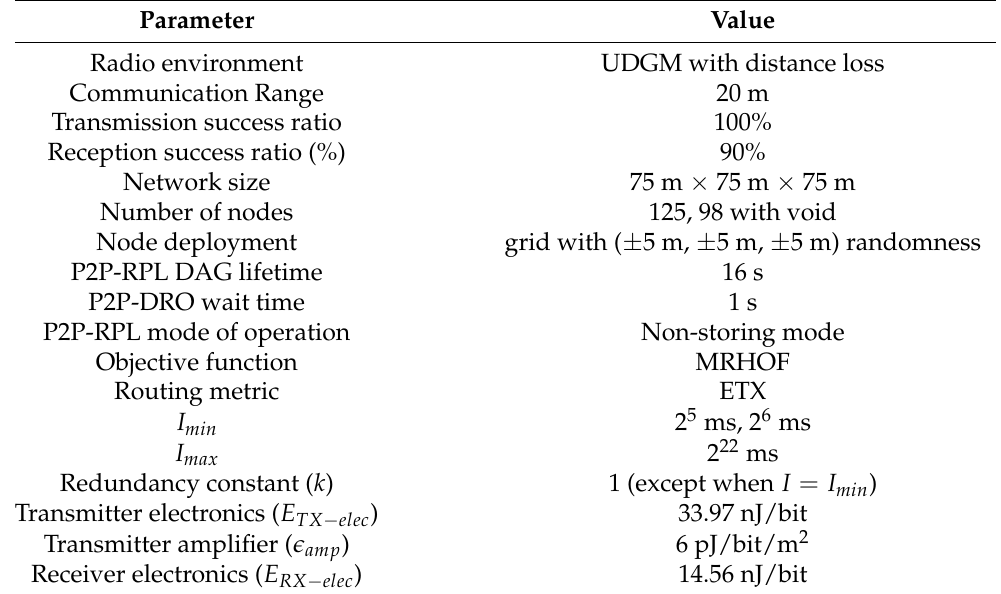
Table 3. Parameter setting for our routing